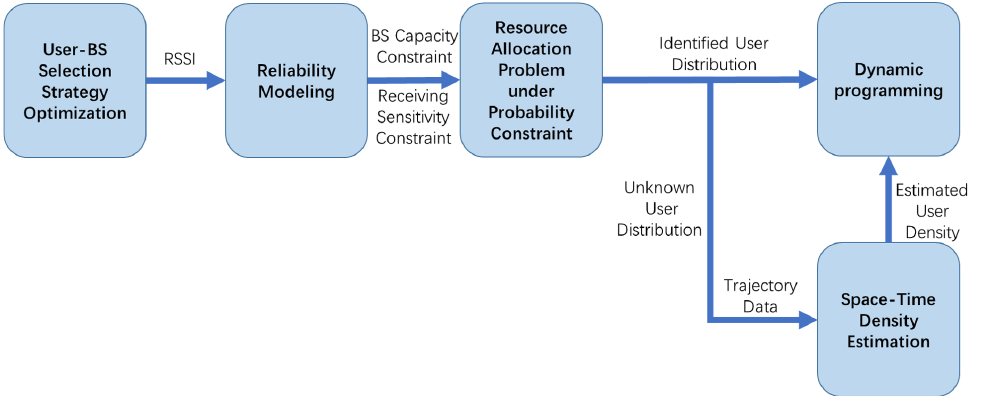
Figure 1. Overall flow of Algorithm 3.